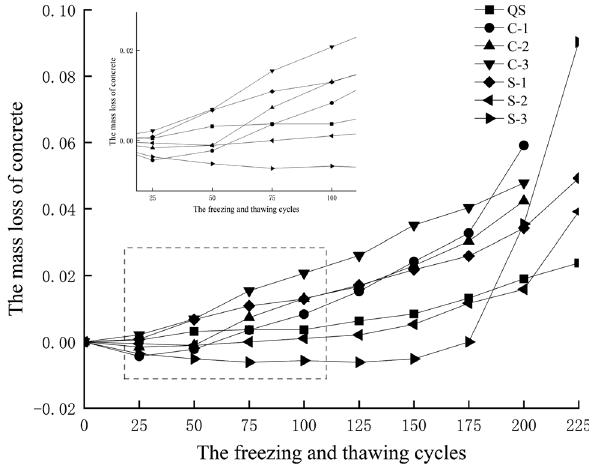
Figure 5: Mass loss of concrete.